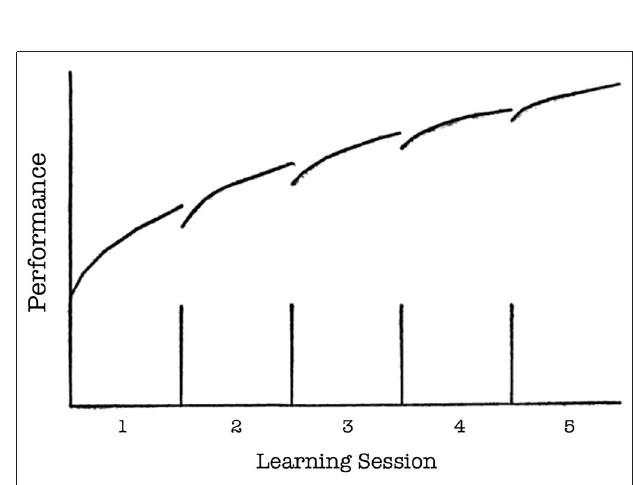
FIGURE 7 | Thorndike’s hypothetical model of memory decay and recovery . The segmented linear curve indicates memory performance ( y axis) over the course of five learning sessions ( x axis). The vertical lines on the x axis indicate four periods of disuse (i.e., periods of time between sessions in which the memory is not retrieved). Performance decreases (i.e., decays) following each period of disuse. However, relearning during a subsequent session results in a stronger memory that is less sensitive to decay. Therefore, decay becomes progressively less pronounced following each subsequent period of disuse (From Thorndike, 1913, p. 283; axis labels